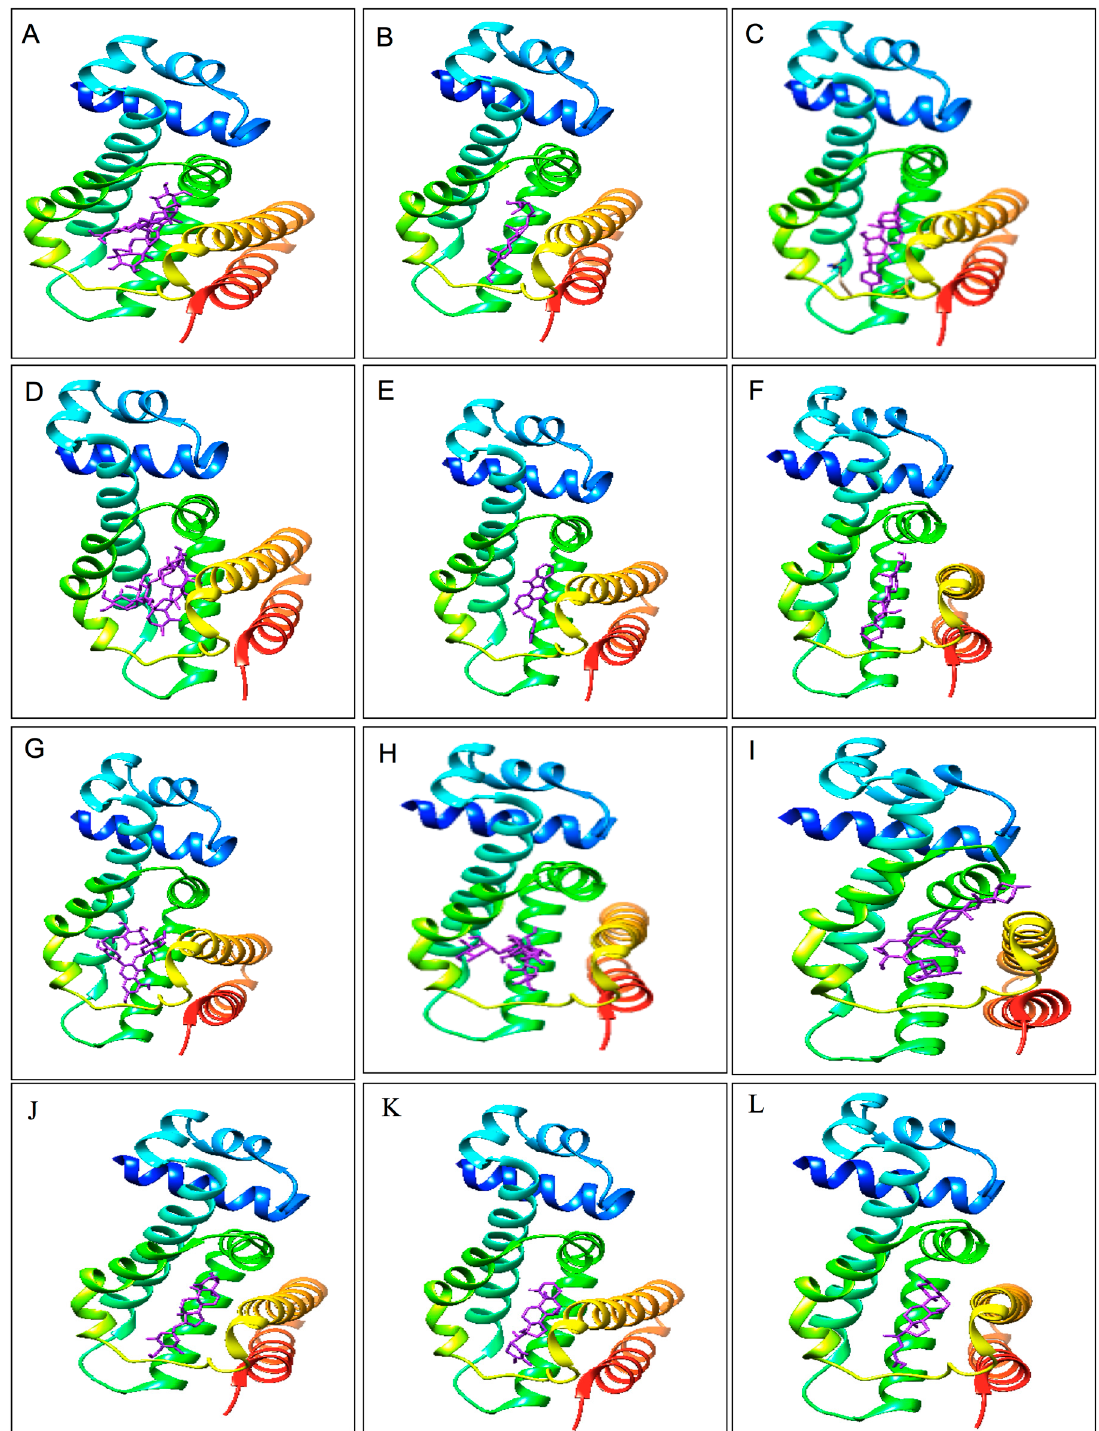
Figure 3. Ribbon structure of 11 active phytocompounds and bile component in complex with RamR protein of Salmonella Typhimurium: ( A ) asiaticoside, ( B ) beta-sitosterol, ( C ) bryophyllin A, ( D ) madecassoside, ( E ) mahanimbine, ( F ) pennogenin, ( G ) rutin, ( H ) solamargine, ( I ) solasonine, ( J ) withaferin A, ( K ) withanone, and ( L ) chenodeoxycholic acid.